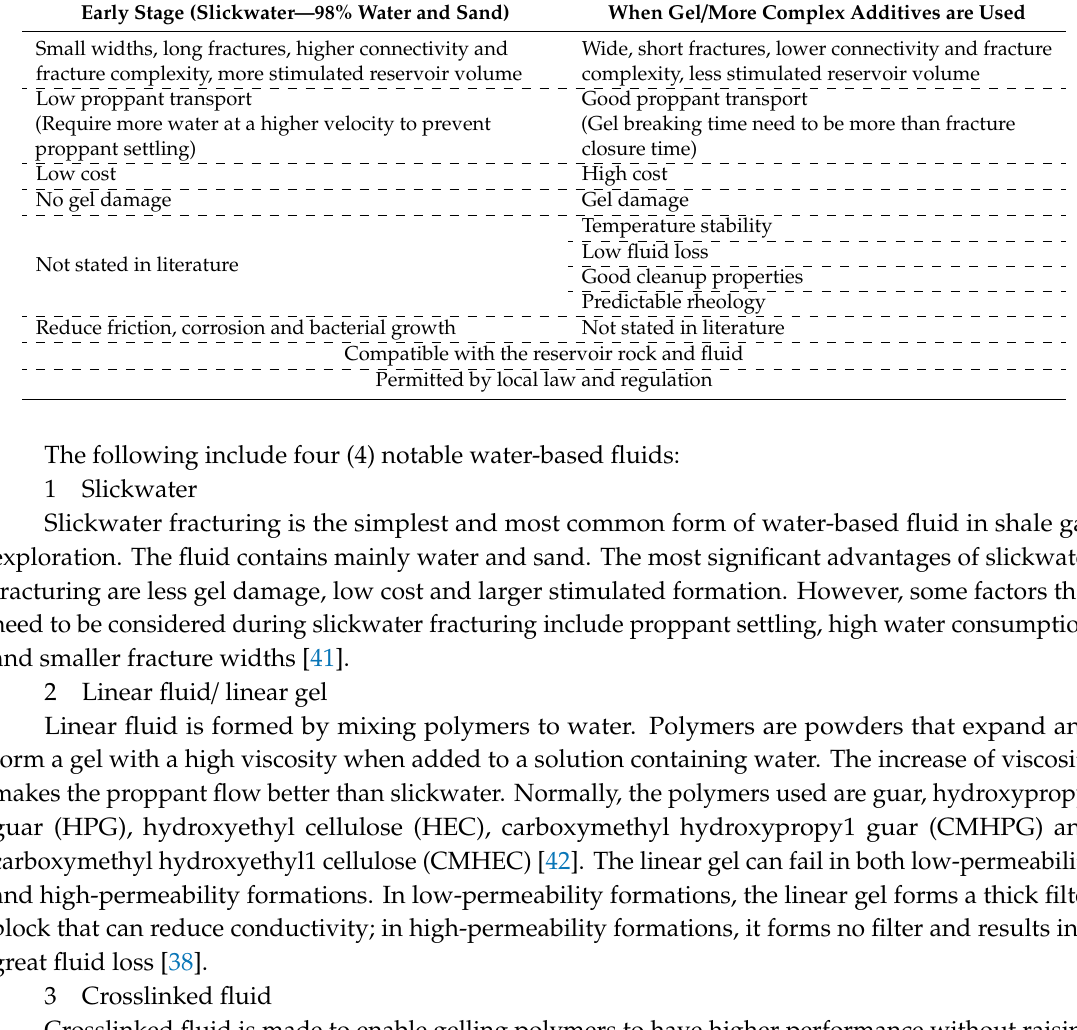
Table 1. Comparison between the characteristics of two side of water-based fluid technologies. Early Stage (Slickwater—98% Water and Sand) When Gel / More Complex Additives are Used Small widths, long fractures, higher connectivity and fracture complexity, more stimulated reservoir volume Low proppant transport (Require more water at a higher velocity to prevent proppant settling)